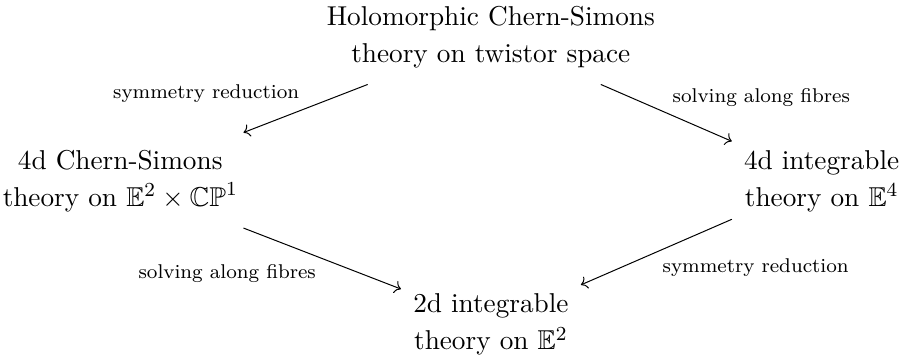
Figure 1 . A guide to the relationship between integrable systems in 2 and 4 dimensions and Chern-Simons type